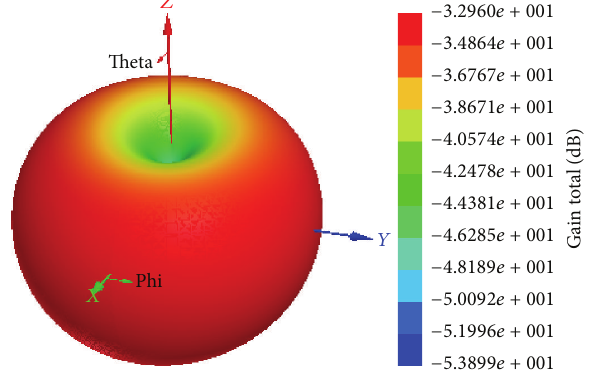
Figure 10: Simulated three-dimensional gain patterns for the proposed implantable antenna at 402MHz.